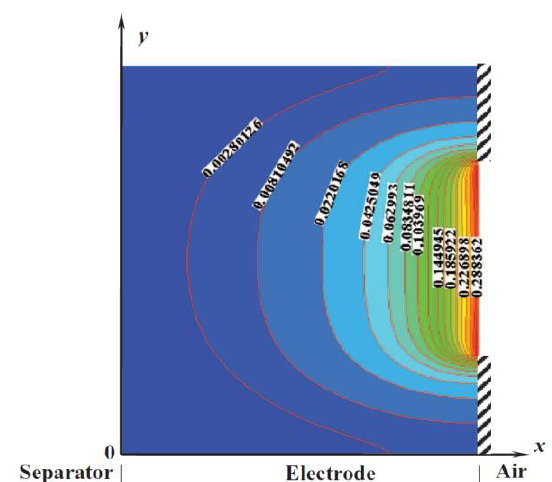
Figure 32. Volume fractions of Li 2 O 2 in the electrode with 50% open ratio after discharge. Electrode is 800-μm thick and discharged at 0.2 mA/cm 2 . Republished from Li and Fargri [45] with permission of The Electrochemical Society conveyed through Copyright Clearance Center, Inc.